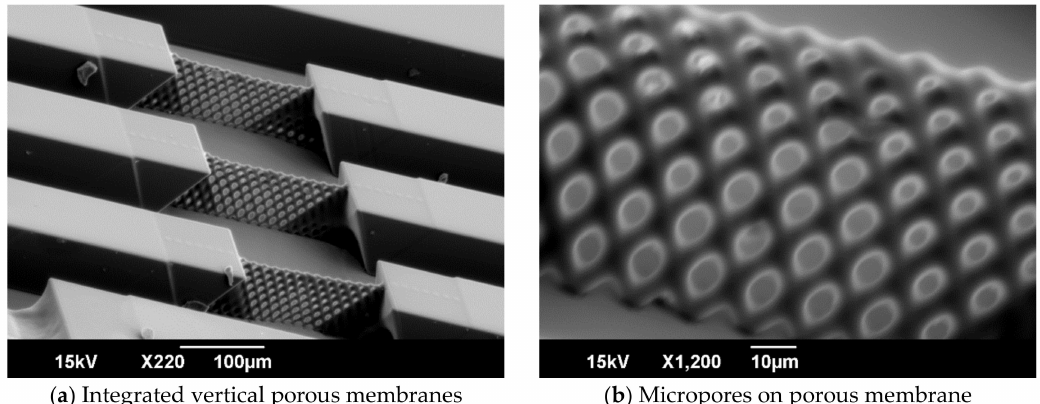
Figure 9. SEM images of fabricated microchannel integrated with vertical porous membranes. The microchannel was fabricated by inclined exposure with exposure dose 420 mJ/cm 2 and double-sided inclined oxygen ashing for 10 min. The SEM images were captured at a 60 ◦ angle. The size of the micropores close to the substrate surface were 6.84 ± 0.59 µ m in width and 9.40 ± 0.22 µ m in height. The size of the micropores close to the top were 4.07 ± 0.30 µ m in width and 4.03 ± 0.19 µ m in